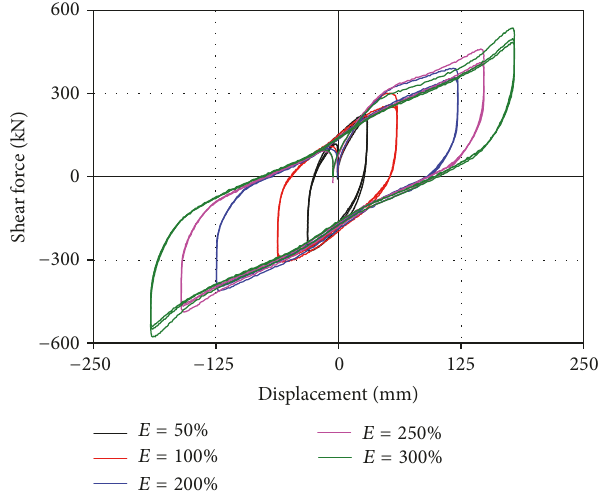
Figure 9: The hysteresis curves of the